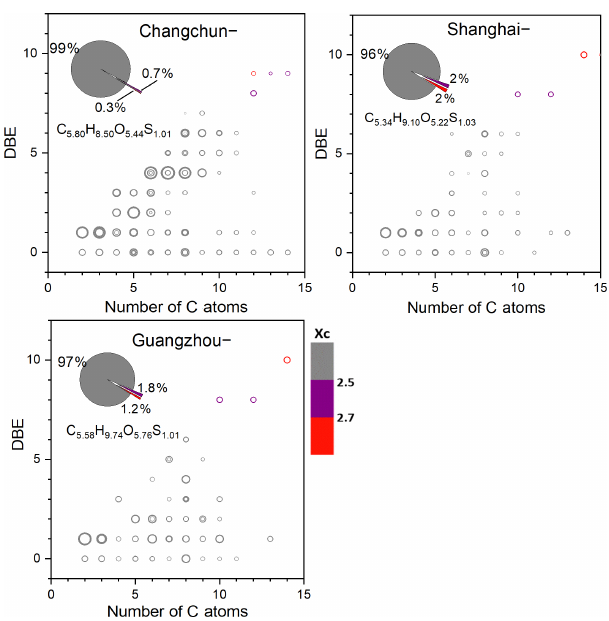
Figure 7. Double bond equivalent (DBE) versus carbon number for all CHOS- compounds for all sample locations. The molecular for- mula represents the abundance-weighted average CHOS- formula, and the area of circles is proportional to the fourth root of the peak abundance of an individual compound (a diagram with circle areas related to absolute peak abundances is presented in Fig. S11). The color bar denotes the aromaticity equivalent (gray with X C < 2 . 50, purple with 2 . 50 ≤ X C < 2 . 70 and red with X C ≥ 2 . 70). The pie charts show the percentage of each X C category (i.e., gray color- coded compounds, purple color-coded compounds and red color- coded compounds) in each sample in terms of peak